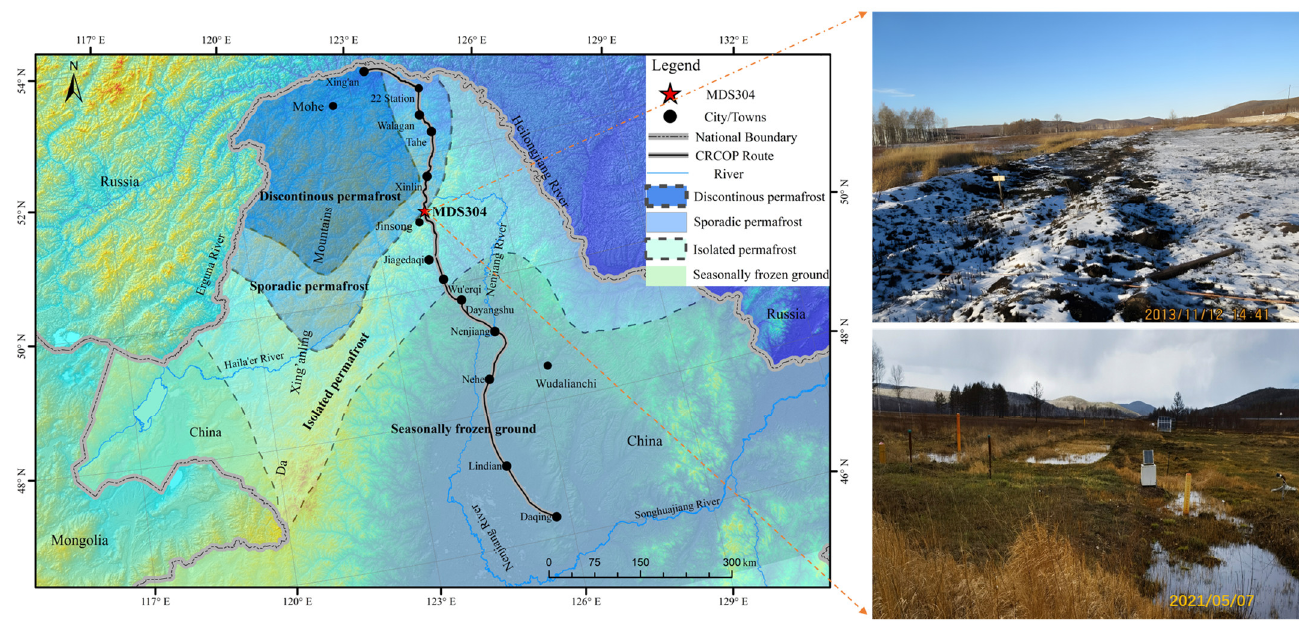
Figure 2. A schematic diagram of the location of the monitoring site, MDS304, and photos were taken in the same location in 2013 and 2021 [38,39,43].